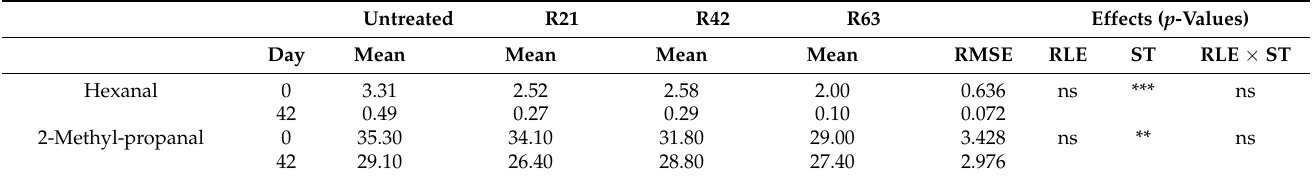
Table 7. Relative abundance (AU × 10 6 ) of four volatile organic compounds selected as possible lipid oxidation markers in salmon p â t é